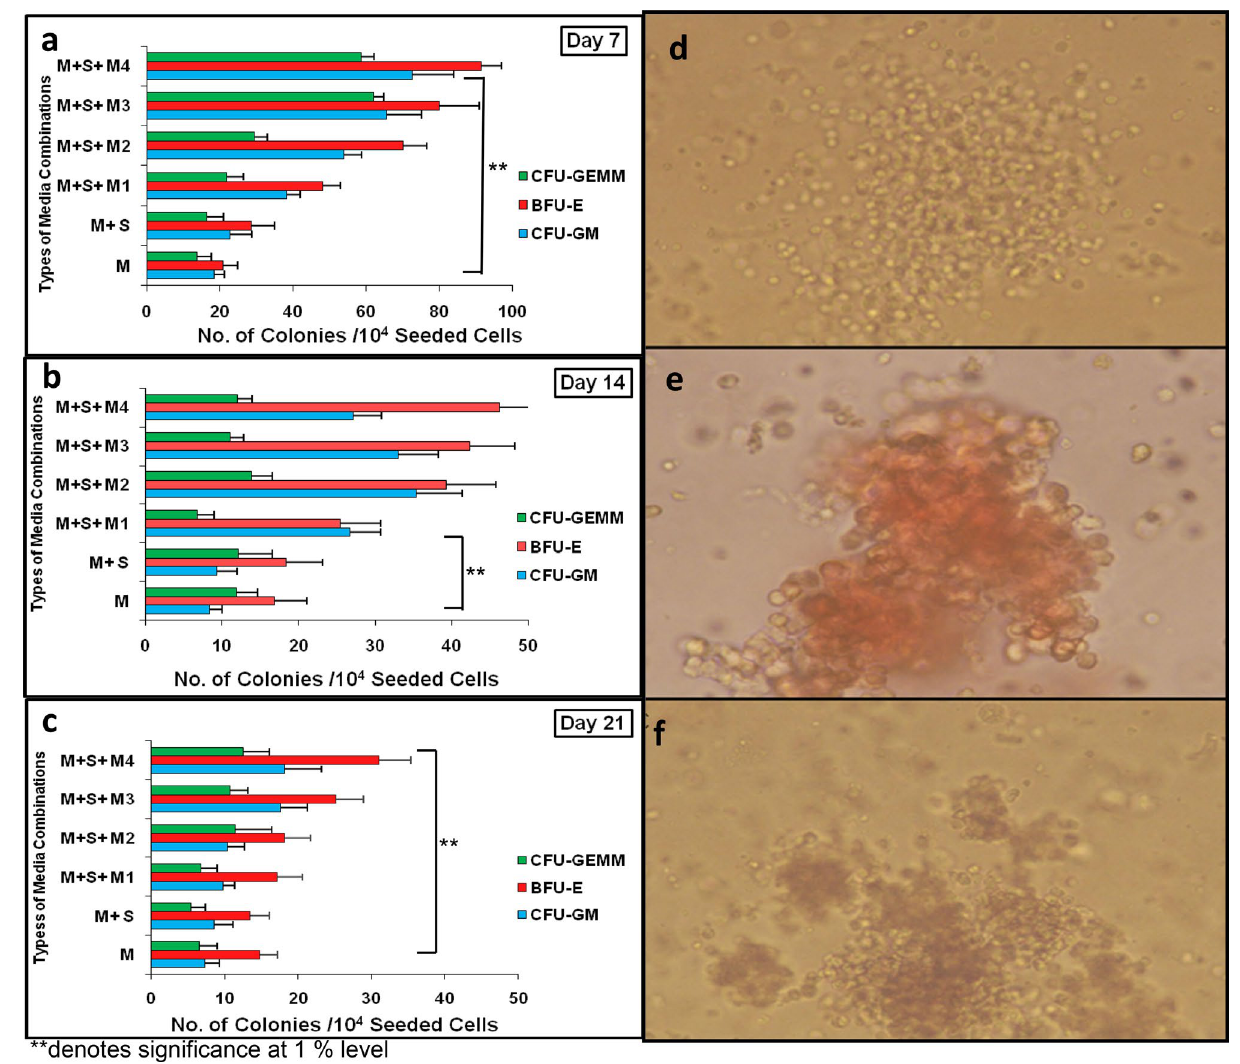
Figure 4. Colony Forming Unit Assay from invitro expanded FL CD34 + HSPCs . Number of committed progenitors (including CFU-GM, BFU-E, and CFU-Mix) derived from 1 × 10 4 Fetal liver CD34 + HSPCs after 7 days ( a ), 14 days ( b ) and 21 days ( c ) of serum-free liquid suspension culture in the presence of different combinations of cytokines.M1, M2, M3 and M4 (n = 3). Statistical significance among colony forming potential from different media combinations as well as days was analyzed via ANOVA and is depicted with asterisks (*). double (**) asterisks indicate P ≤ 0.01. Representative Picture of CFU-GM ( d ), BFU-E ( e ) and CFU-Mix ( f ) colonies derived from Fetal liver CD34 + HSPCs (10×) from combination M + S + M4, day 14 of